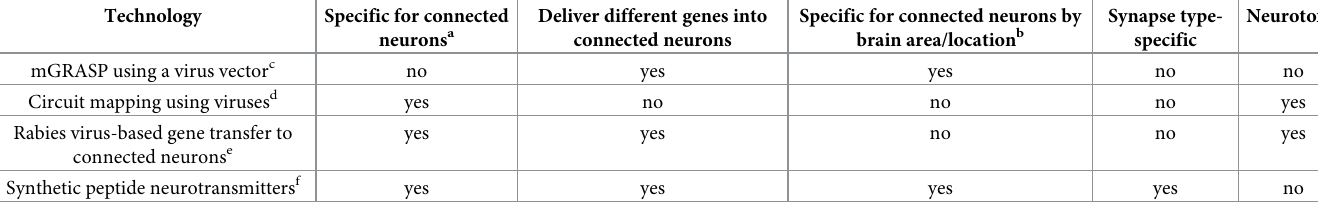
Table 1. Comparison of the different technologies for delivering genes into connected